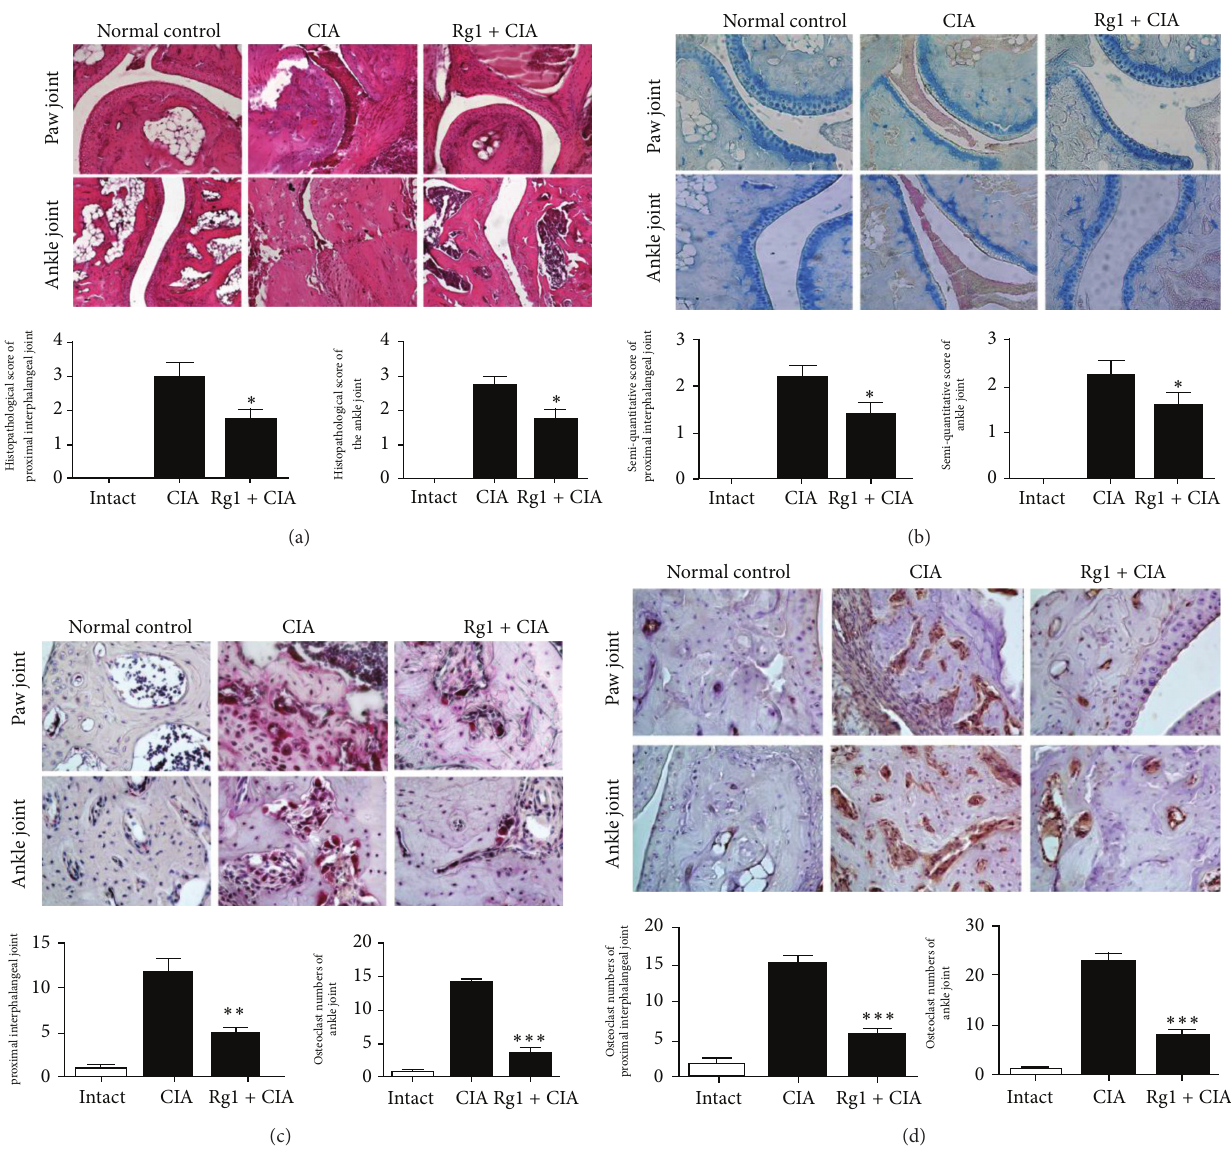
Figure 7: Rg1 resulted in reduced histological inflammation, cartilage loss, and OC formation in CIA mice. (a) Histological evaluations of antiarthritis effects of Rg1 were observed in joint slides stained by HE (original magnification, 200x). Histologic scores in the sections shown in (a). (b) Representative histopathologies of proximal interphalangeal joint, and ankle joint stained with Alcian blue in CIA (original magnification, 200x). Histologic analysis of cartilage in CIA mice after Rg1 therapy. Sections were scored in a blinded manner on a four-point scale as described in Materials and Methods section. A significantly less loss of Alcian blue staining was observed in animals treated with Rg1 than compared to controls, indicating inhibition of cartilage destruction. (c) Trap staining in ankle joints and proximal interphalangeal joint isolated from normal, CIA, and Rg1-treated mice. The expression of Trap significantly decreased in Rg1-treated mice compared with CIA mice. (d) Immunohistochemical staining for cathepsin K in ankle joints and proximal interphalangeal joint isolated from normal, CIA, and Rg1-treated mice. The expression of cathepsin K significantly decreased in Rg1-treated mice compared with CIA mice. Data are the mean ± SD, 𝑛 = 8 mice. ∗ 𝑃 < 0.05 versus CIA treated with